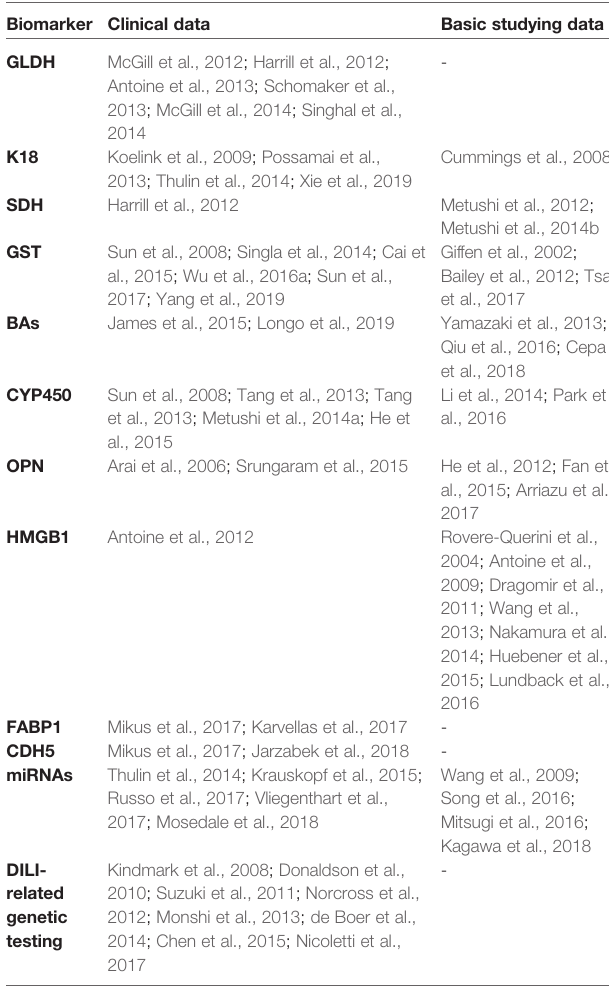
TABLE 4 | Studies of Clinical and Basic Studying Data in